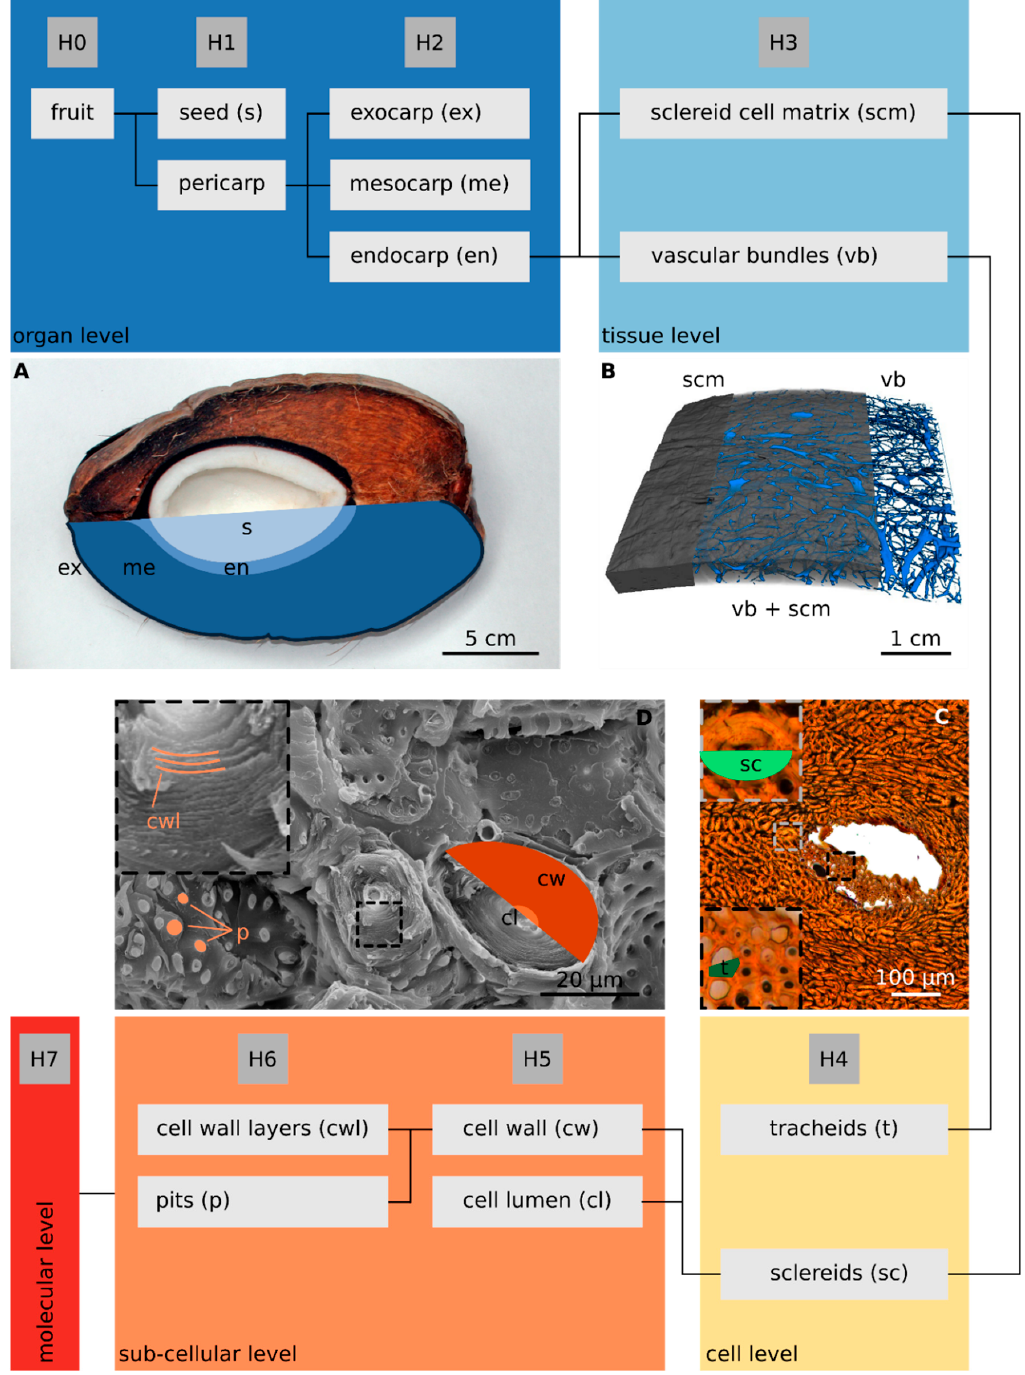
Figure 1. Hierarchical levels of the coconut fruit with illustrations of the important parameters of each level. ( A ) Photograph of an entire fruit cut in half in a longitudinal direction. ( B ) Computer tomography (CT)-reconstruction of an endocarp sample (scan resolution: 42 µm). ( C ) Light microscopy (LM) image of a polished thin section of the endocarp showing the cross section of a vascular bundle in the sclereid cell matrix. ( D ) SEM micrograph of a fractured endocarp surface showing details of the sclereid cell matrix. Table 1 provides the corresponding morphological parameters. H0–H7: Eight hierarchical levels; cl: Cell lumen, cw: Cell wall, cwl: Cell wall layers, en: Endocarp, ex: Exocarp, me: Mesocarp, p: Pits, s: Seed, sc: Sclereids, scm: Sclereid matrix, t: Tracheids, vb: Vascular bundles.